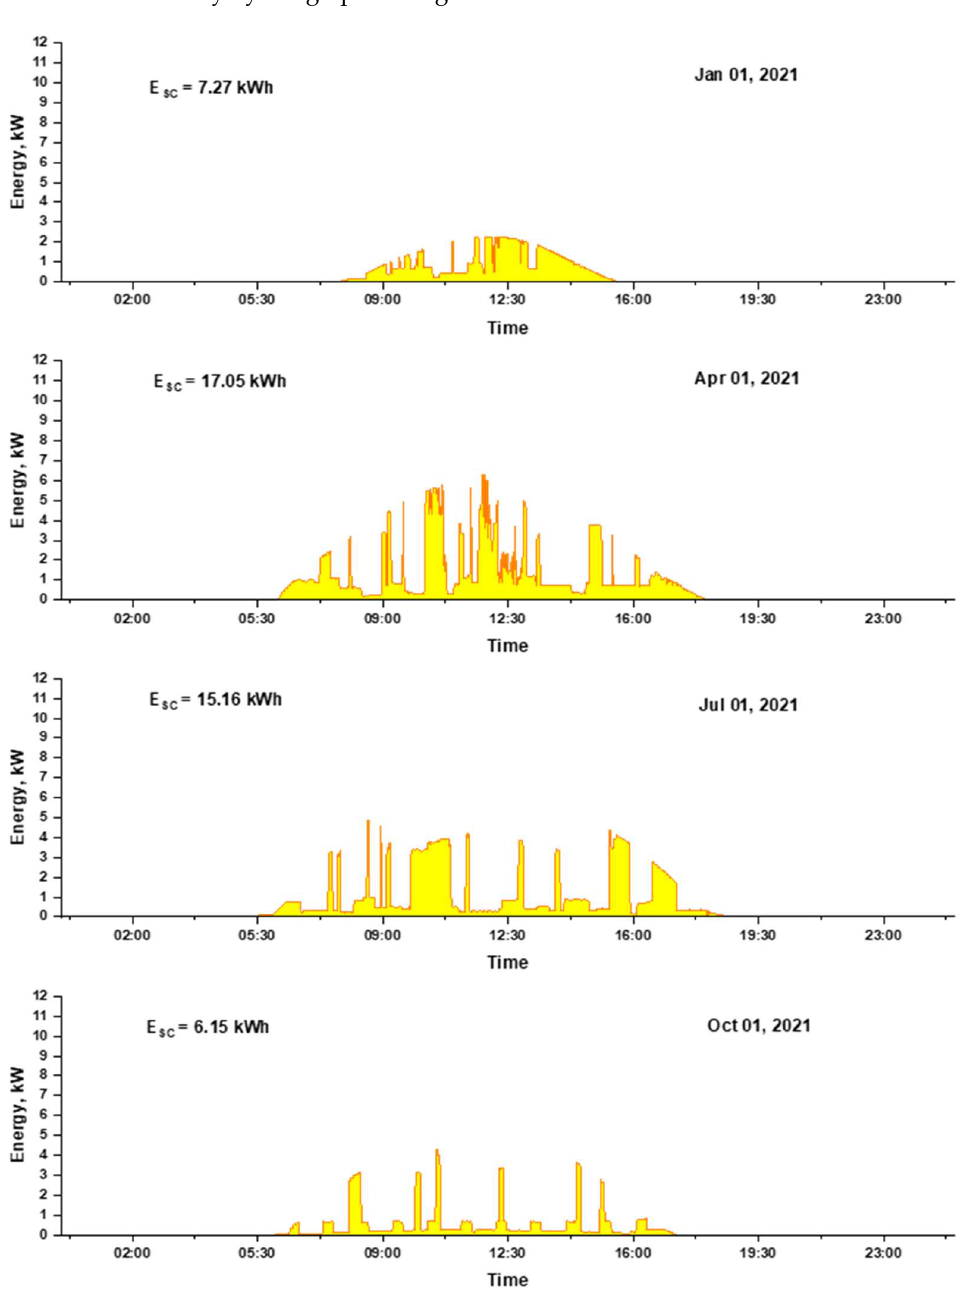
Figure 8. The daily self-consumption energy for four seasonal days using only a photovoltaic array.